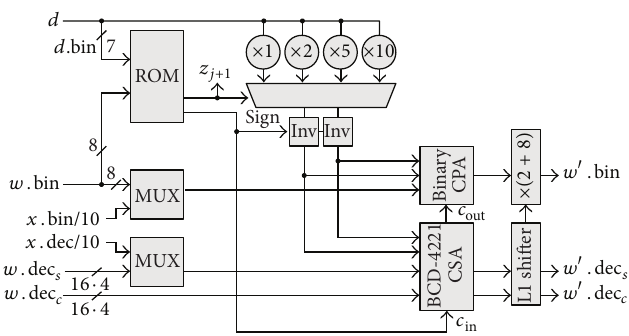
Figure 3: Block diagram of type2 digit recurrence.